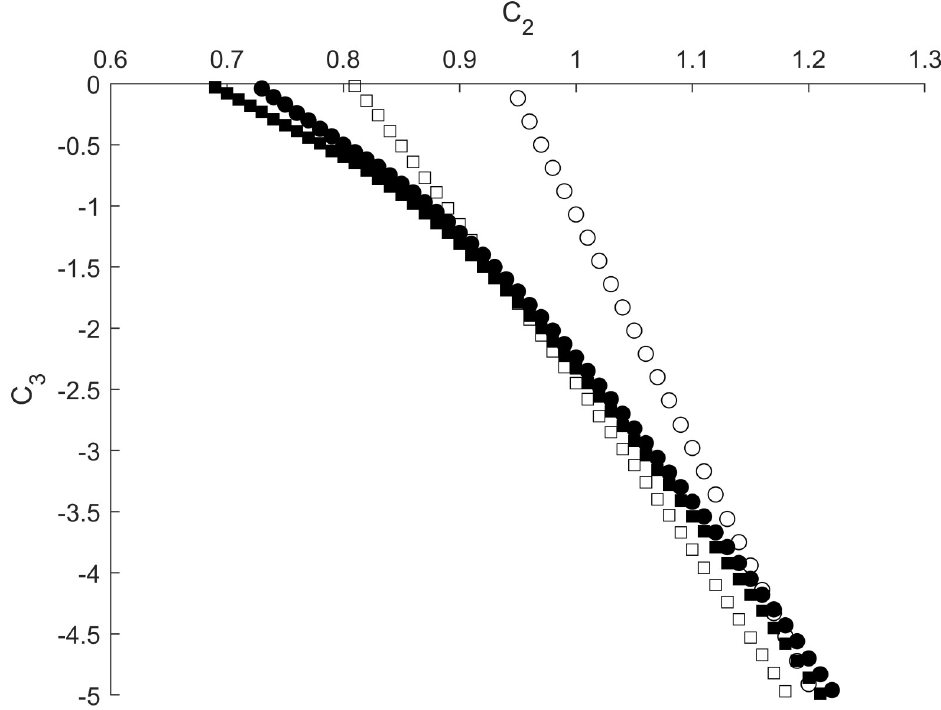
Fig 8. Sensitization-habituation boundaries depicted as dependences of C 3 on C 2 for different values of ϕ and g K ( g = 0.45). Open and filled shapes correspond to ϕ = 0.017 and ϕ = 0.0017, respectively. Circles and squares L correspond to g = 2.5 and g = 1.8, respectively. Other parameters are fixed at values shown in Table K k